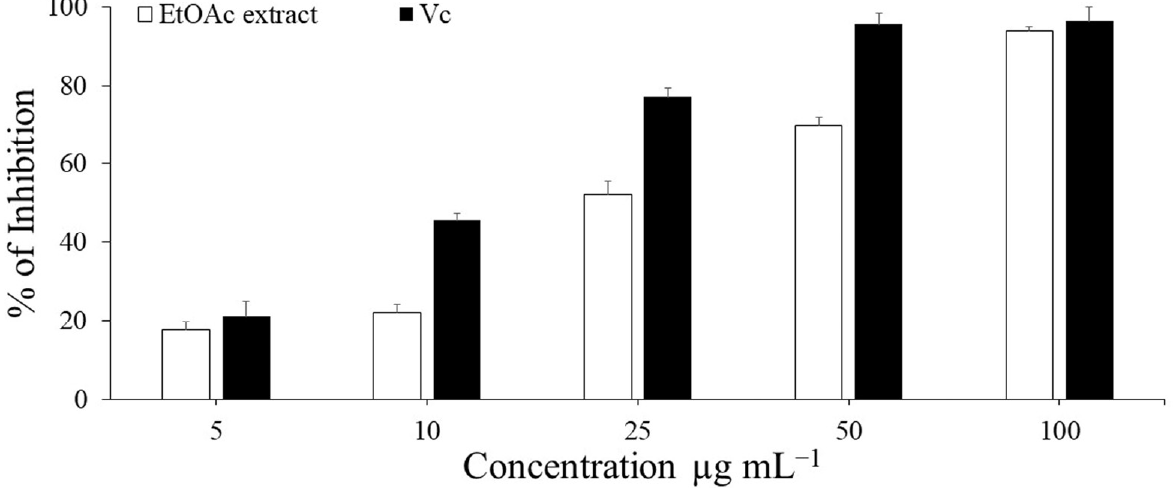
Figure 2. DPPH radical scavenging activity of EtOAc extract of P. neglecta the standard antioxidant (Vc) at different concentrations (5–100 µg mL − 1 ). The IC 50 values of Vc and EtOAc extract were determined from the equations by y= 0.6873x + 41.041 and y= 0.7937x + 20.921, respectively. Each value is expressed as mean ± SD ( n = 3).